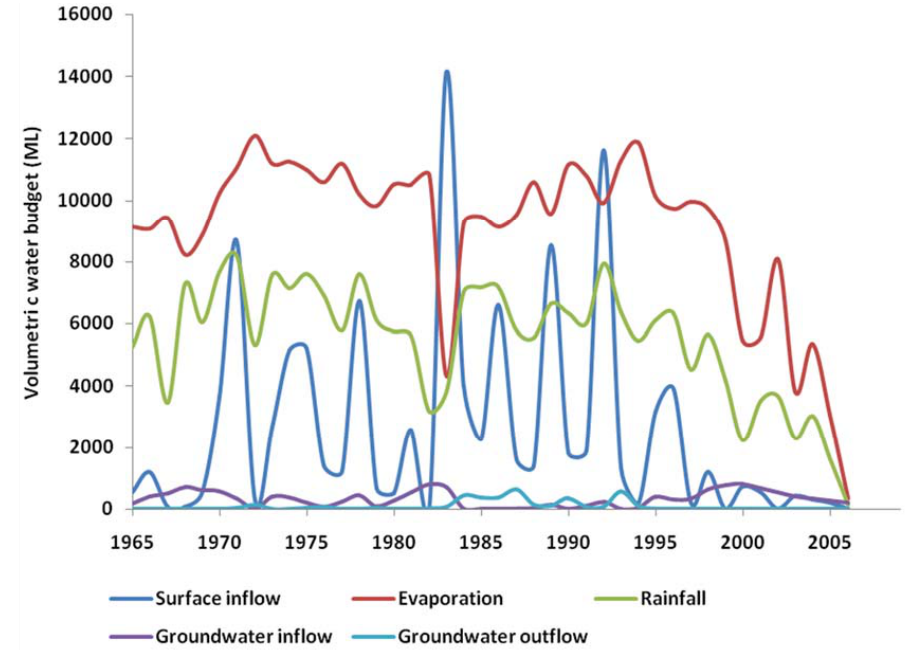
Figure 14. Annual water balance of Lake Linlithgow (1965–2006).